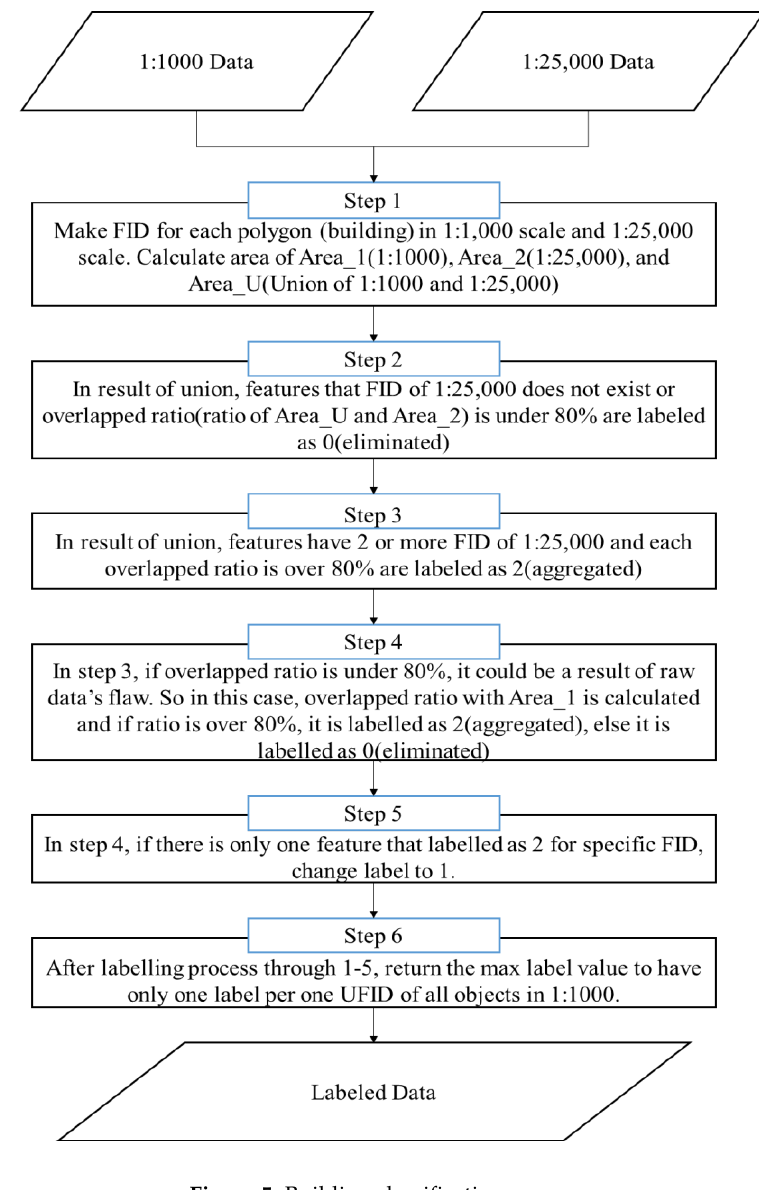
6 of 14 Figure 4. Examples of labeled buildings: ( a ) 0-eliminated; ( b ) 1-retained; ( c ) 2-aggregated (green =